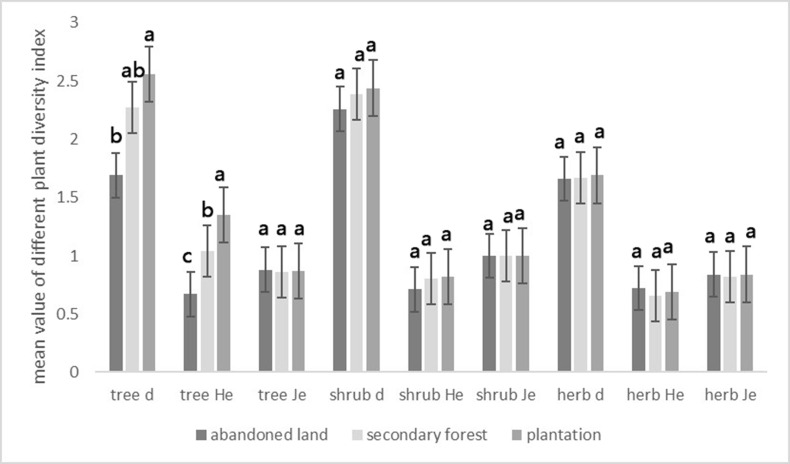
Plant diversity indices of different life forms in different land use types.Error bars were constructed with one standard deviation of the means. Here, d refers to Berger-Parker index, He refers to Shannon index, Je refers to Pielou evenness index. Different letters represented significant differences at p = 0.05 among the three different vegetation types.